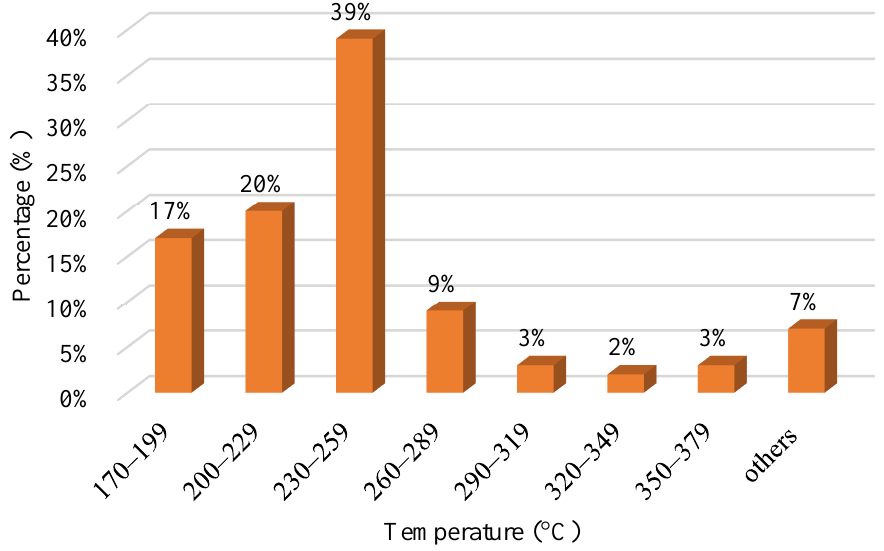
Figure 8. Range of nozzle temperature for various material via FDM process.